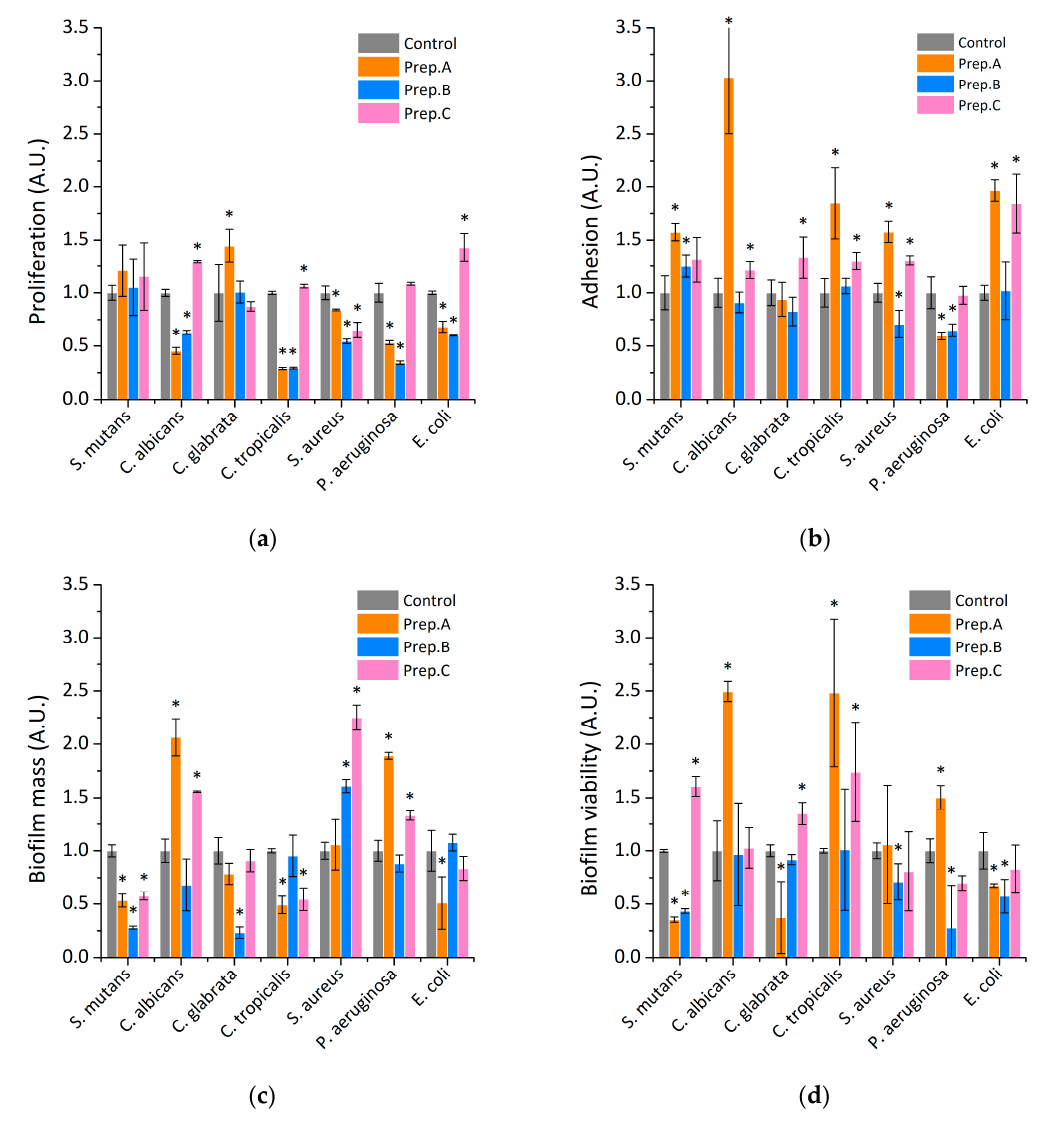
Figure 1. The effect of tested artificial saliva preparations on the growth of representative oral microorganism. Panel ( a ) indicate the ability of tested preparations to restrict their division. Panel ( b , c ) shows the influence of tested saliva preparations on the initial stage (adhesion) and the formation of biofilm. Viability of the cell embedded in the biofilm matrix after treatment by tested saliva formulations are presented at panel ( d ). Statistical significance for the tested preparations compared to control was marked by (*) p ≤ 0.05. The data showed medium results from three measurements ±SD.